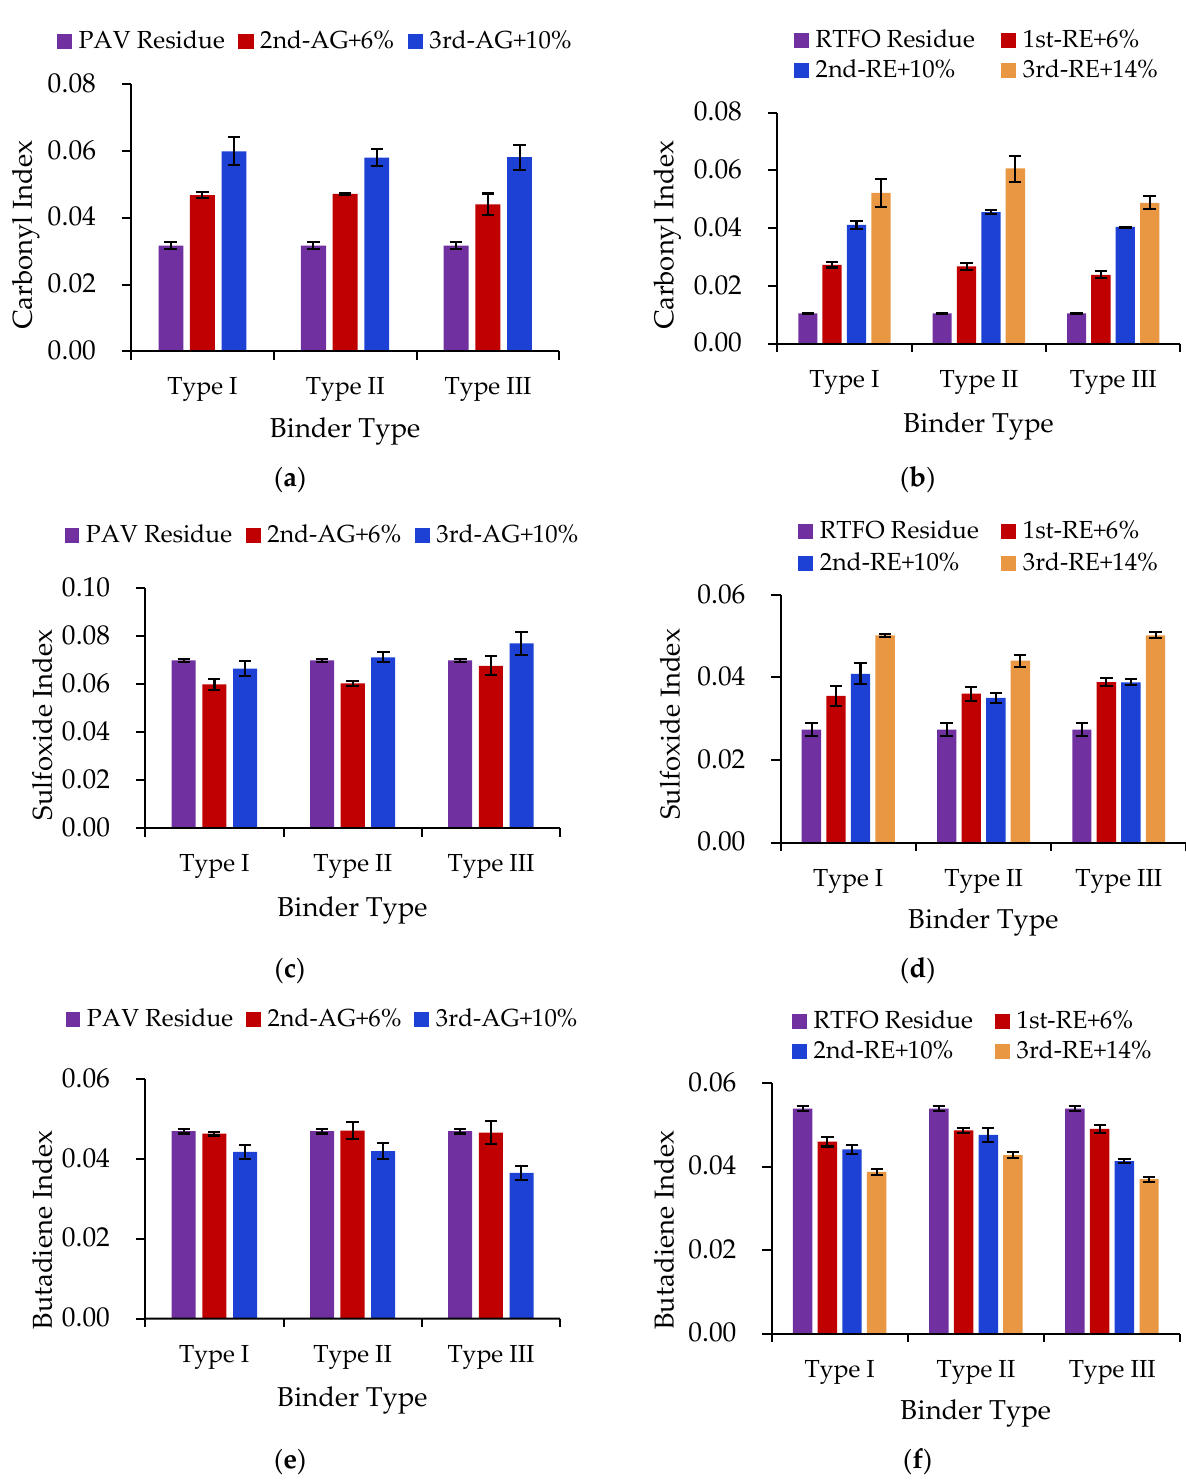
Figure 10. Chemical aging indices of repetitively aged and rejuvenated SBSMA: ( a ) AG − CI; ( b ) RE − CI; ( c ) AG − SI; ( d ) RE − SI; ( e ) AG − BI; ( f ) RE − BI.